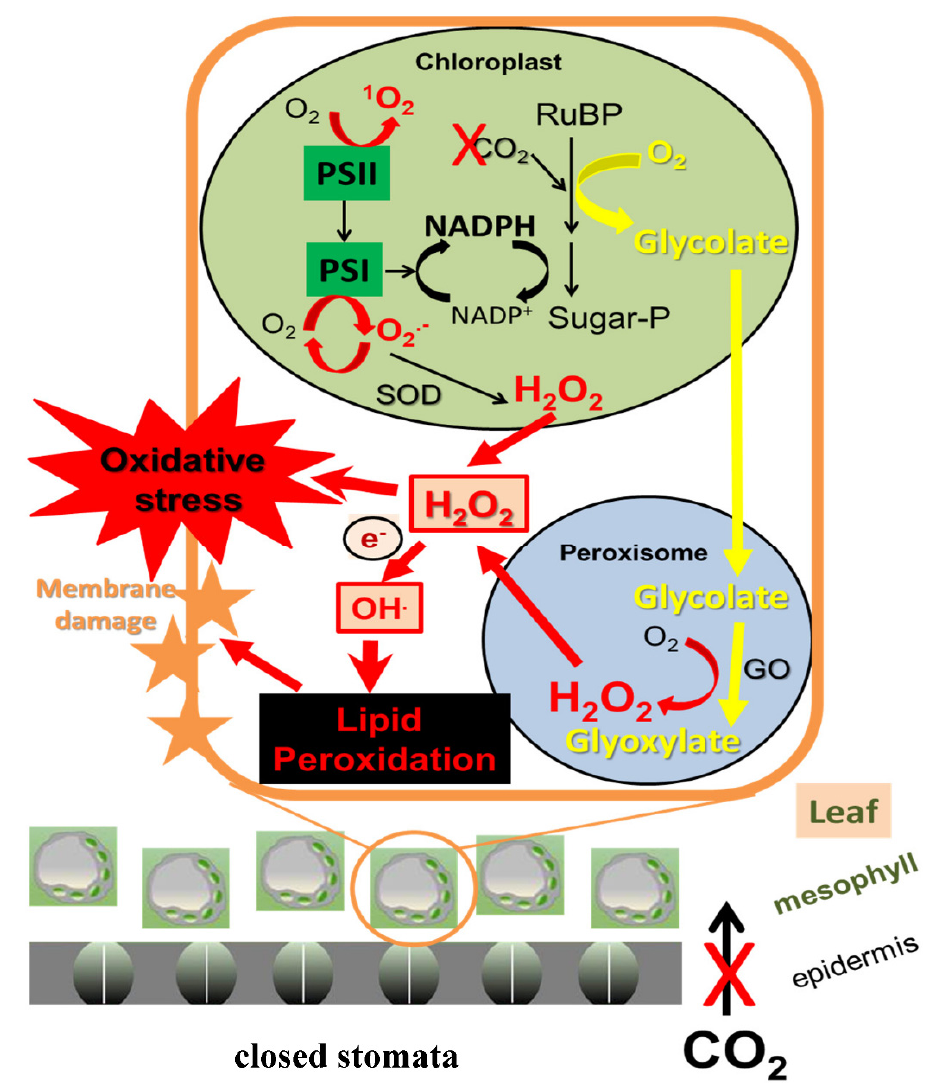
Figure 3. Drought stress may cause excessive accumulation of ROS due to perturbations in photosynthesis, resulting in oxidative stress within plant cells. Drought-induced closure of stomata restricts carbon dioxide (CO 2 ) uptake, causing overaccumulation of reduced photosynthetic electron transport components (e.g., NADPH) in chloroplasts and increased oxygenation of ribulose-1,5-bisphosphate (RuBP). This accelerates the production of glycolate. In peroxisomes, glycolate is converted to glyoxylate and hydrogen peroxide (H 2 O 2 ) by glycolate oxidase (GO), accounting for most of peroxisomal H 2 O 2 production in green tissues of C3 plants. These processes also favor the chloroplastic accumulation of the ROS superoxide (O 2 •− ), singlet oxygen ( 1 O 2 ) and H 2 O 2 by the photosynthetic electron transport chain (PSI and PSII). H 2 O 2 from chloroplasts and peroxisomes may be transferred to the cytoplasm, where massive oxidative stress and membrane lipid peroxidation may develop, especially due to the action of the H 2 O 2 -derived hydroxyl radical (OH • ). Based on Noctor et al. [56] and Nadarajah